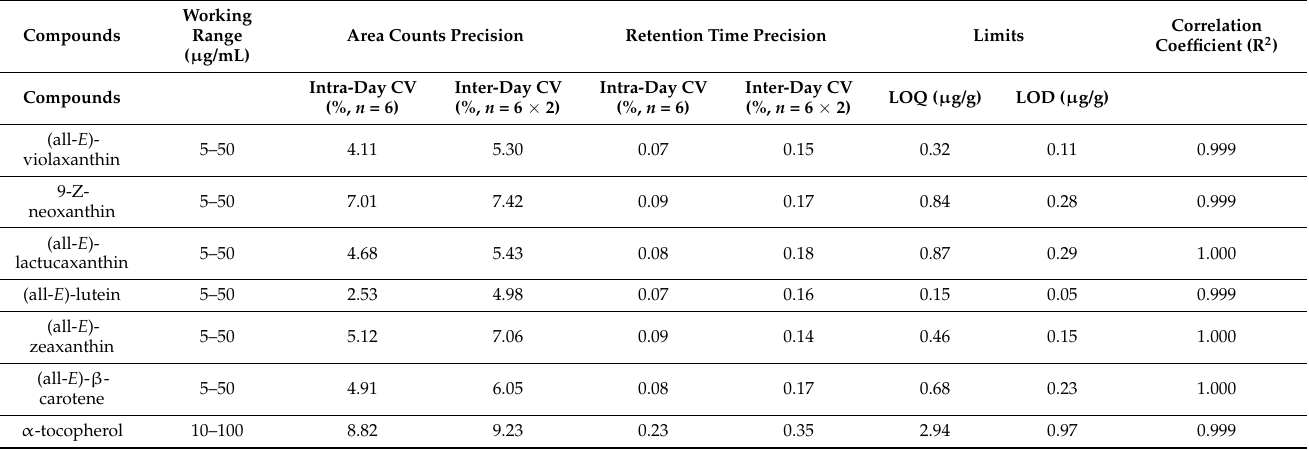
Table A1. The validation parameters for the liquid chromatography–mass spectrometry with a single ion monitoring (LC-MS/SIM) analysis of carotenoids and